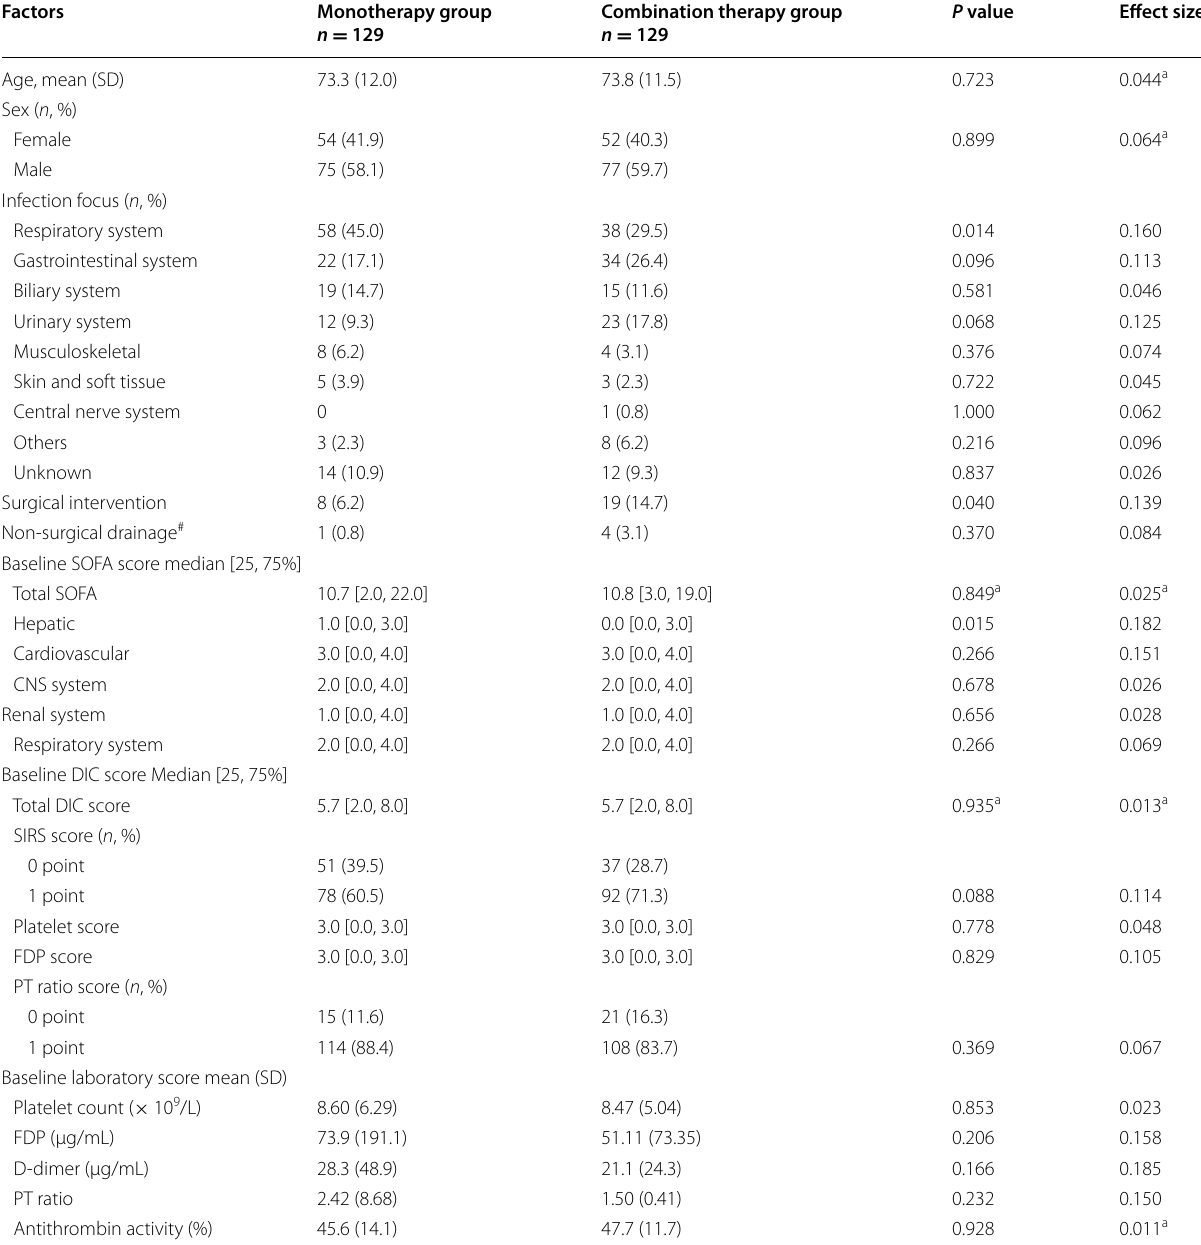
Table 2 The baseline characteristics of the patients after propensity score matching ( n